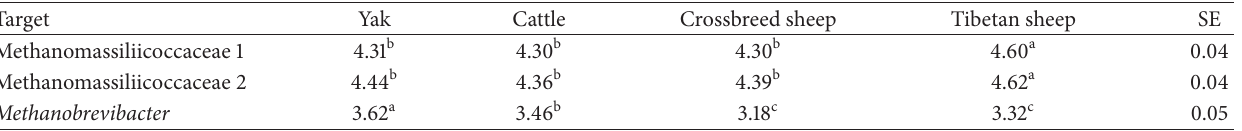
Table 3: Abundance of Methanomassiliicoccaceae and Methanobrevibacter (log copy gene numbers g −1 ng DNA) in ruminant species.